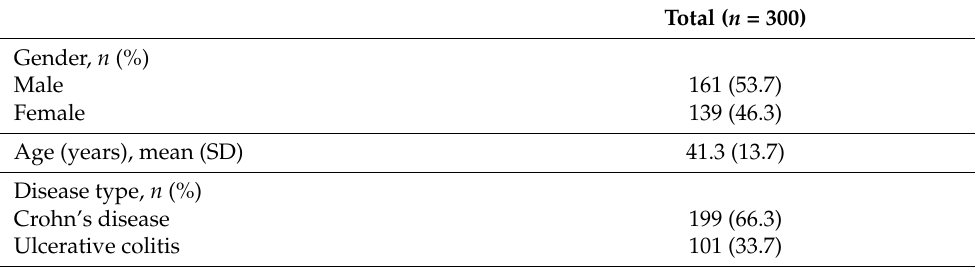
Table 1. Clinical characteristics of the study participants at baseline ( n =